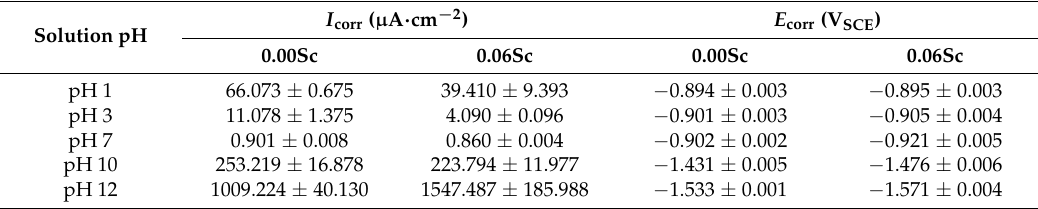
Table 3. Electrochemical parameters obtained from I / E Tafel slope analyses from Figure